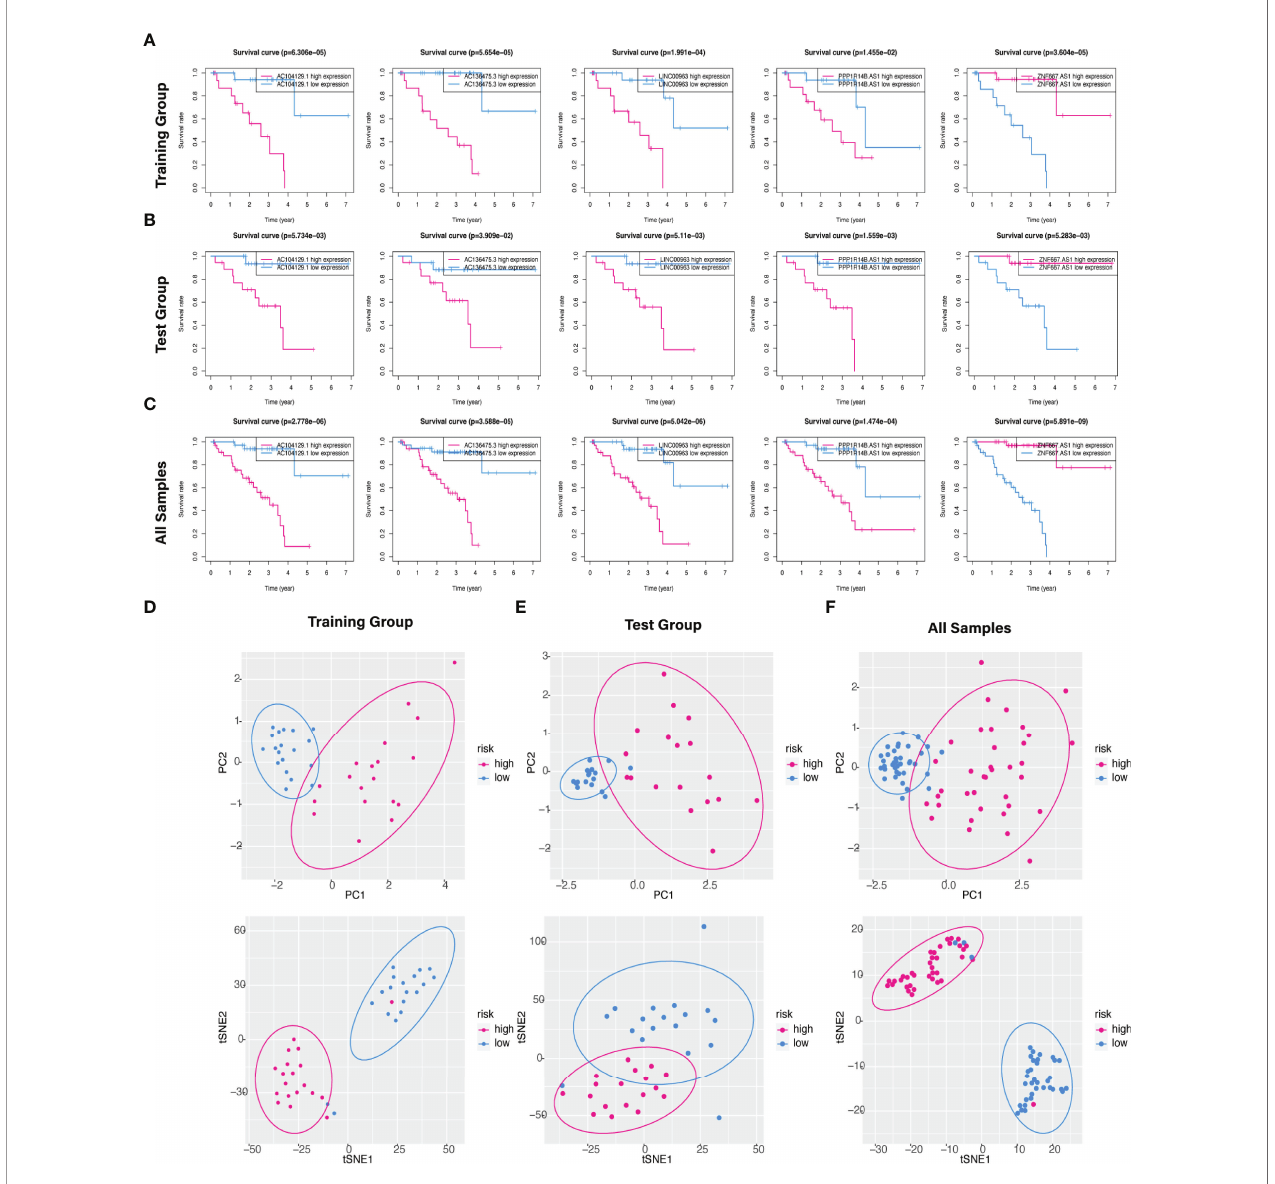
FIGURE 6 | Kaplan – Meier survival analysis of fi ve hub FRLs and discrimination analysis of the risk score. (A – C) The K-M survival curve analysis of the fi ve optimal FRLs signature (AC104129.1 AC136475.3, LINC00963, and PPP1R14B.AS1, and ZNF667.AS1) in the (A) training, (B) test, and (C) all cohorts. (D – F) PCA and t-SNE diagrams of genome-wide expression pro fi les of TCGA-UM in the (D) training, (E) validation, and (F) all groups,